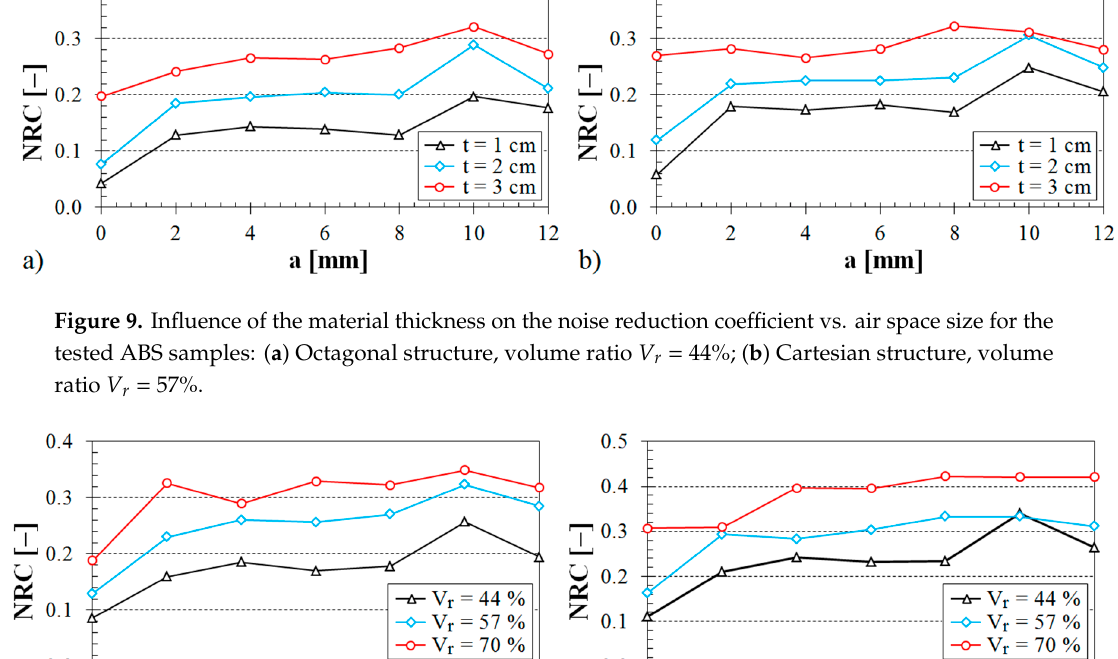
Figure 11. Influence of the 3D-printed ABS material structure on the noise reduction coefficient vs. material thickness for the investigated ABS samples: ( a ) volume ratio V r = 44%, air space size a = 10 cm; ( b ) volume ratio V r = 70%, air space size a = 4 cm.